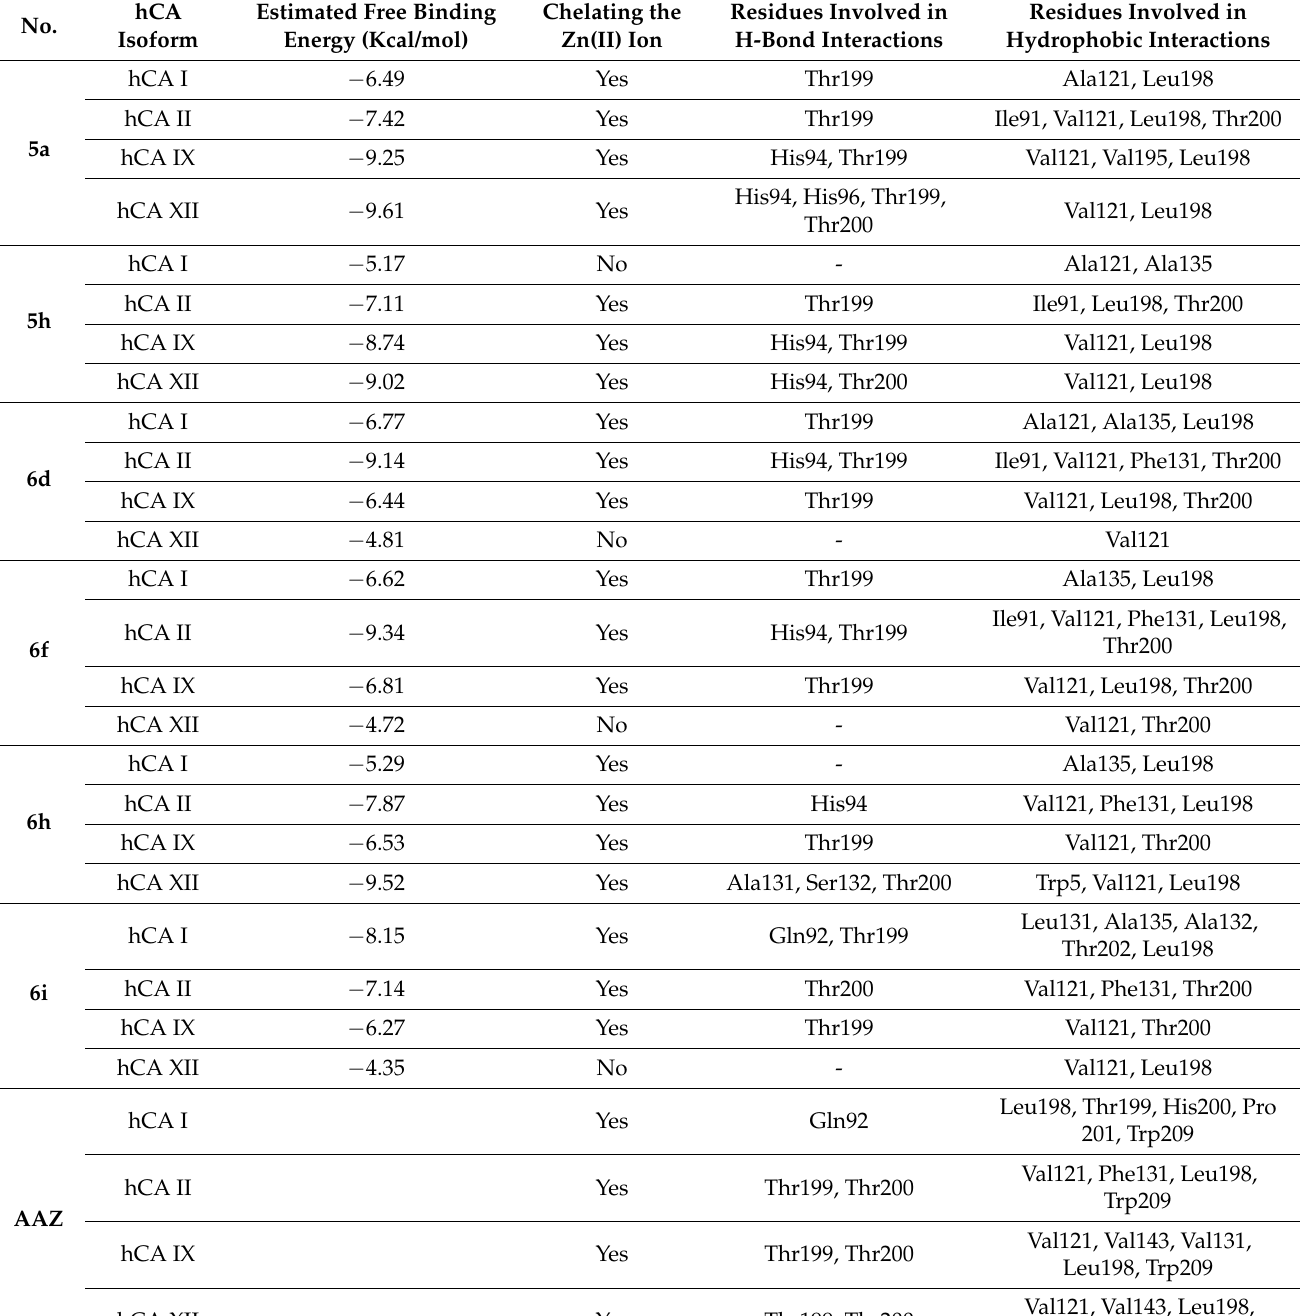
Table 2. Molecular docking free binding energies (kcal/mol) and interactions of tested compounds on hCA I, II, IX, and XII